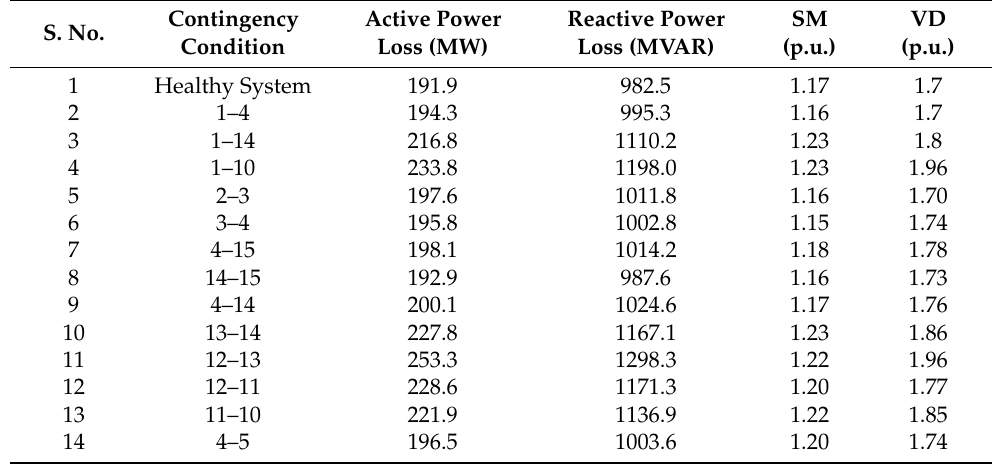
Figure 3. Indian Utility 62 bus system. Table 1. Sample results for major Line Contingency Study of the 62 bus Transmission System.